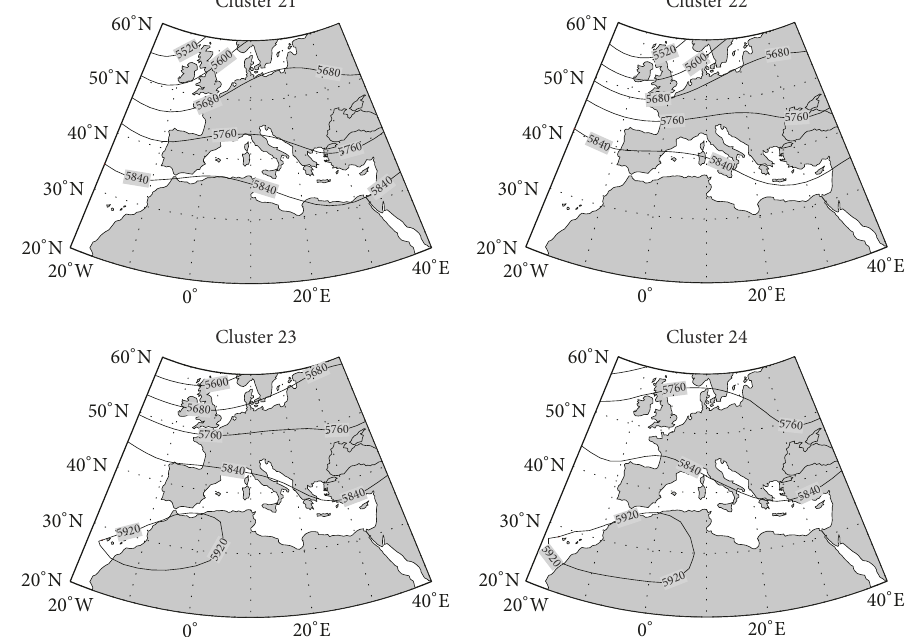
Figure 6: Average spatial distribution of the 500 hPa isobaric surface, associated with each of the 24 classes. Contours are drawn for every 80 geopotential meters.